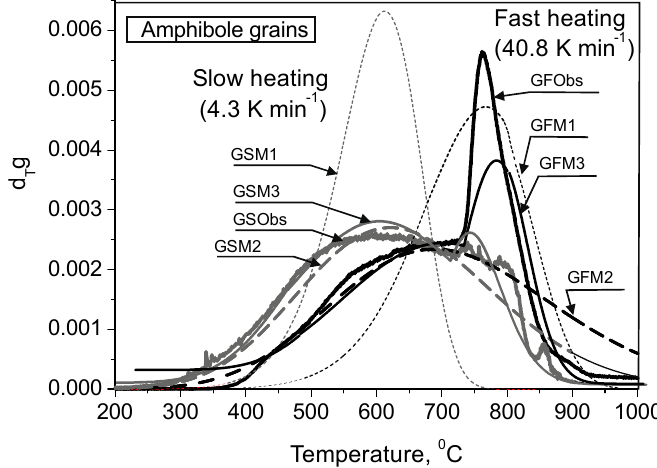
Figure 3. Comparison of the He release patterns (the He flux, K − 1 , versus the temperature, OC), measured in the course of slow (curve Grain Slow Observed, GSObs) and fast (GFObs) incremental heating of the amphibole grains, with the modeling results. 4He amounts extracted from the grain samples in the course of slow and fast heating were 5.1 × 10 − 10 and 1.1 × 10 − 9 mol, respectively.